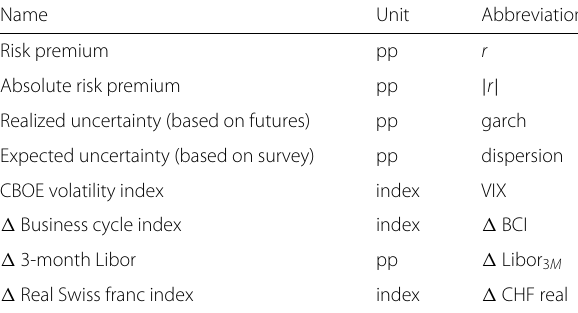
Table 4 Description of regression variables